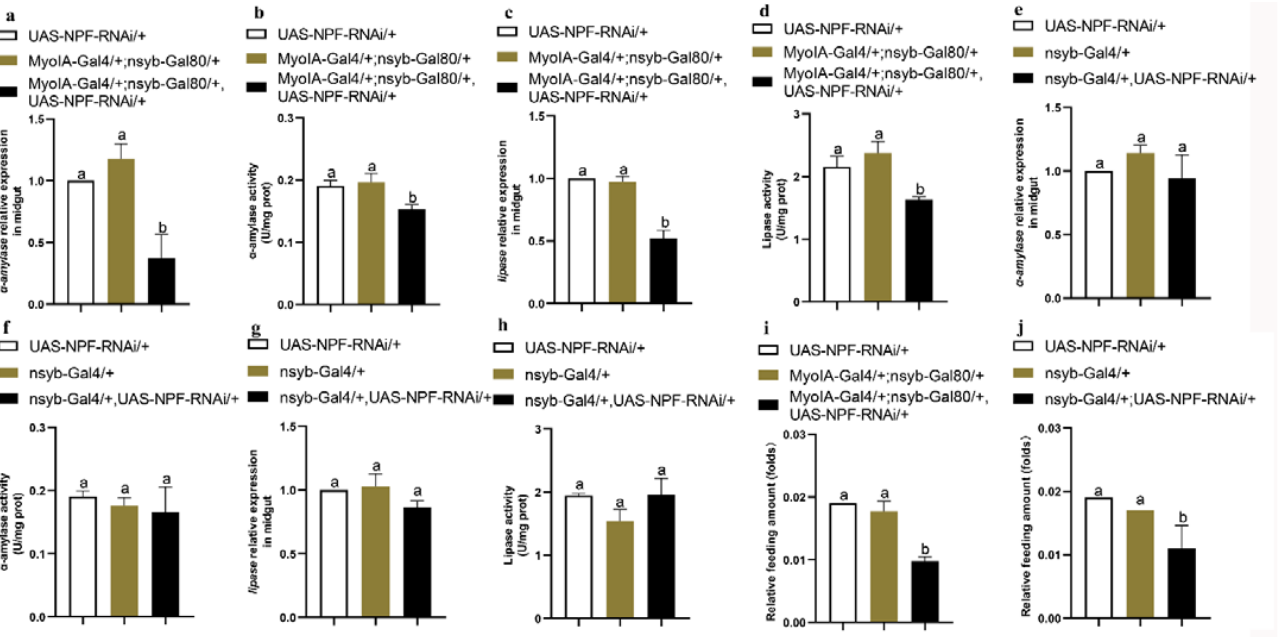
Figure 8. Effects of brain and gut knockdown of npf on larval feeding and digestion of D. melanogaster